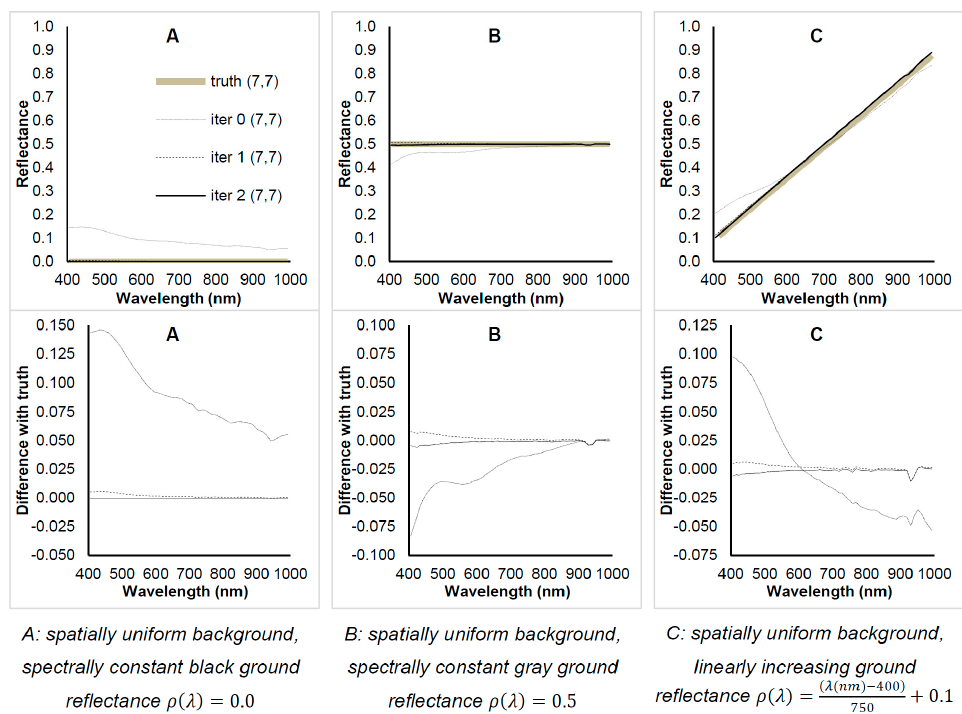
Figure 4. Reflectance spectra for the pixels A to C as the number of iterations increases. The pattern of surrounding pixels affects the first retrieval (iteration 0). The retrieved reflectance converges to the real value after the subsequent iterations. Both the reflectance spectra (at the top ) and their difference with the ground truth (at the bottom ) are shown.